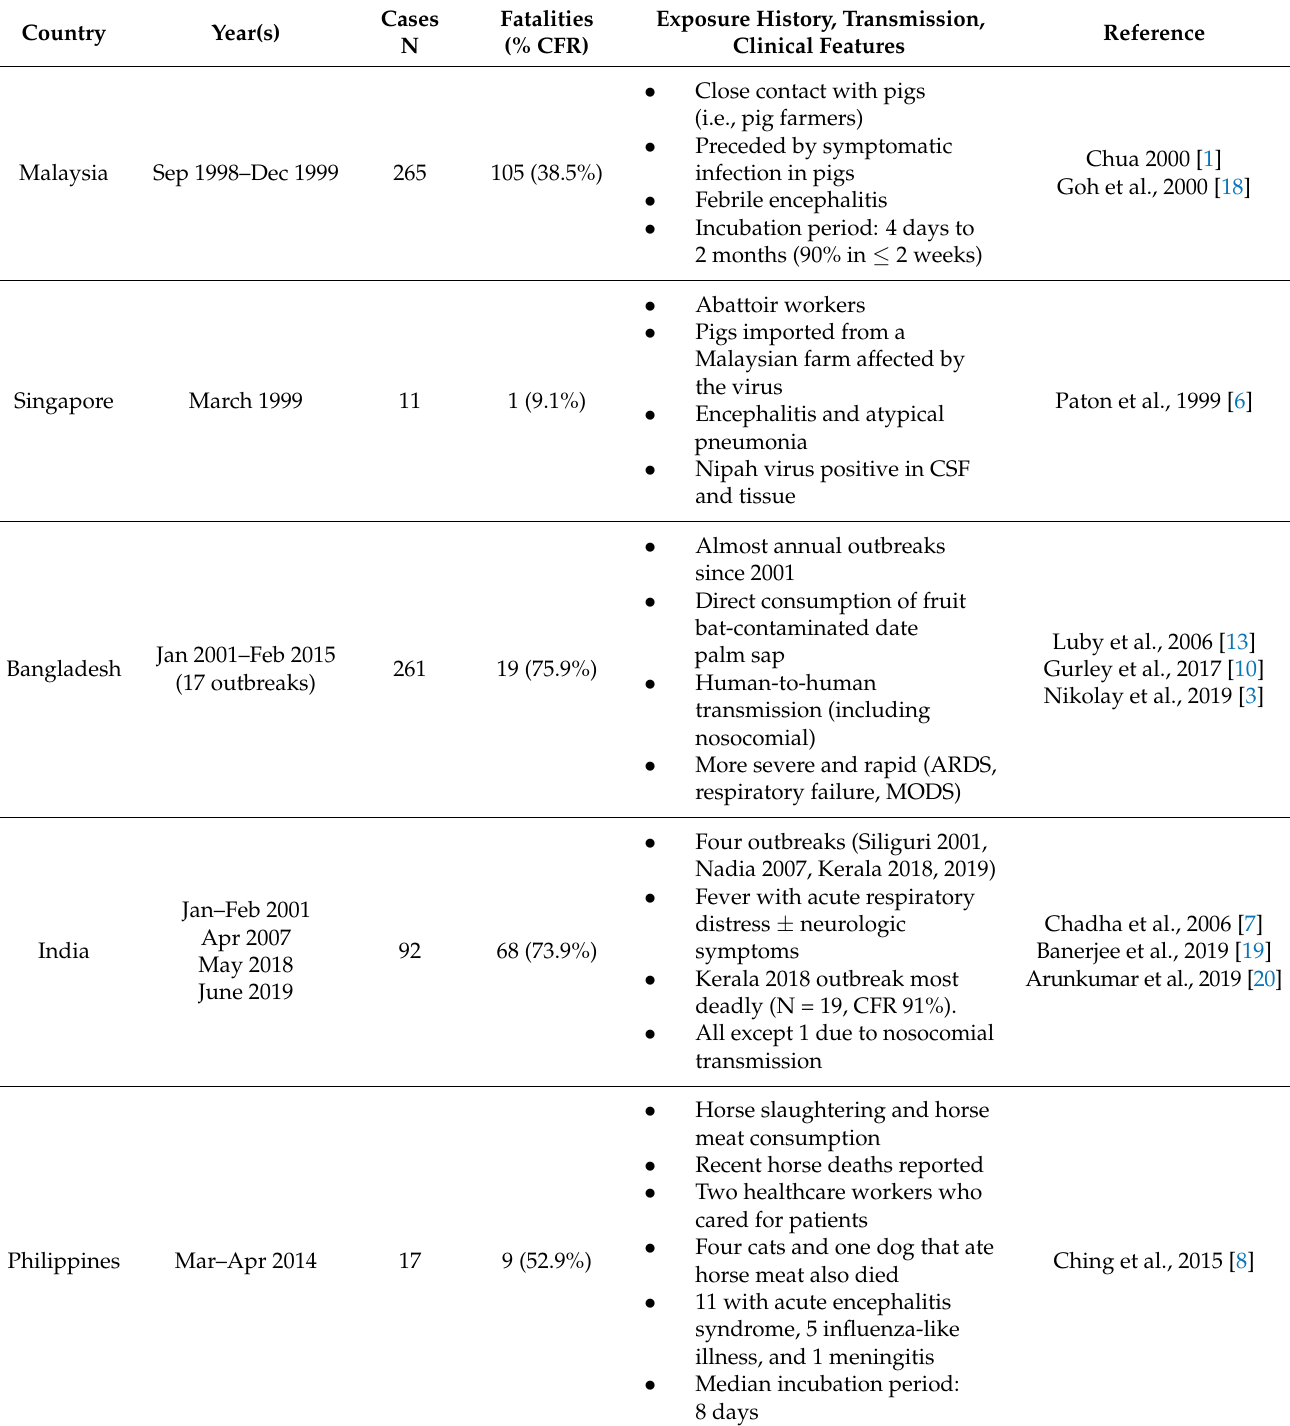
Table 1. Nipah virus outbreaks listed in chronologic order with case fatality rates, exposure history, and clinical features. Legend—ARDS: acute respiratory distress syndrome; CFR: case fatality rate; CSF: cerebrospinal fluid; MODS: multiorgan dysfunction